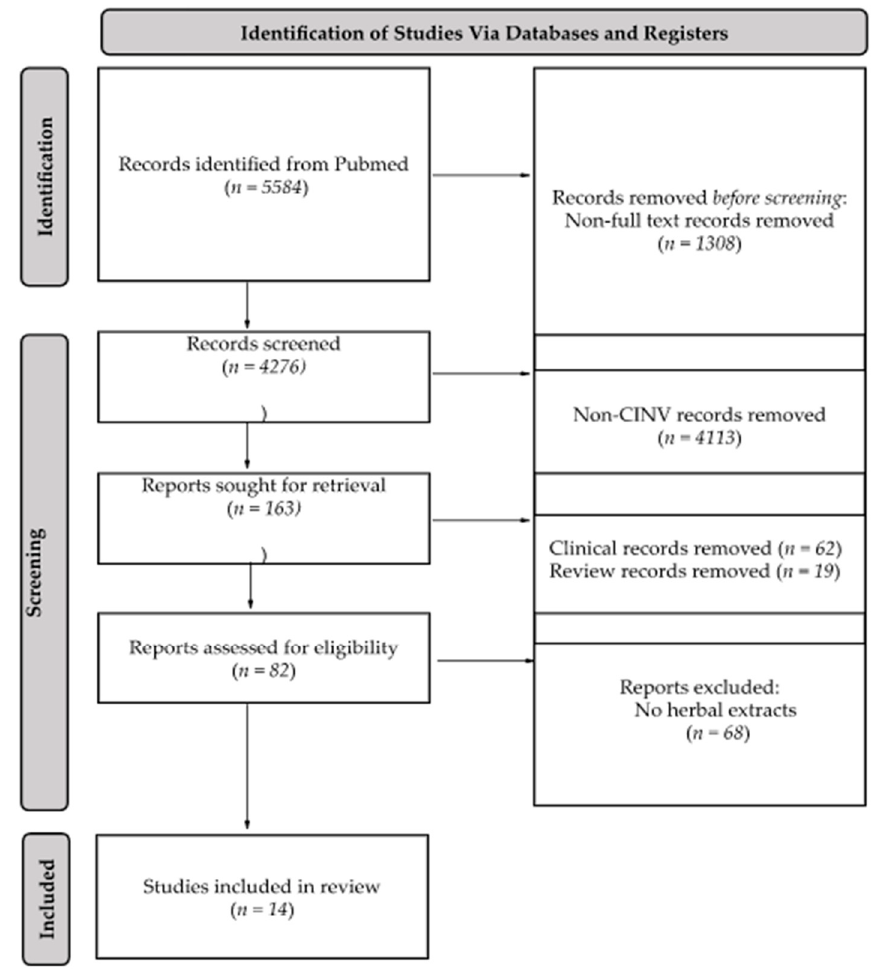
Figure 1. Flow chart of article inclusion protocol. In total, 5584 articles were screened by abstract and full-text examinations. Finally, a total of 14 articles assessing the effect of herbal extracts in cisplatin-induced nausea and vomiting in animals were included in our review.